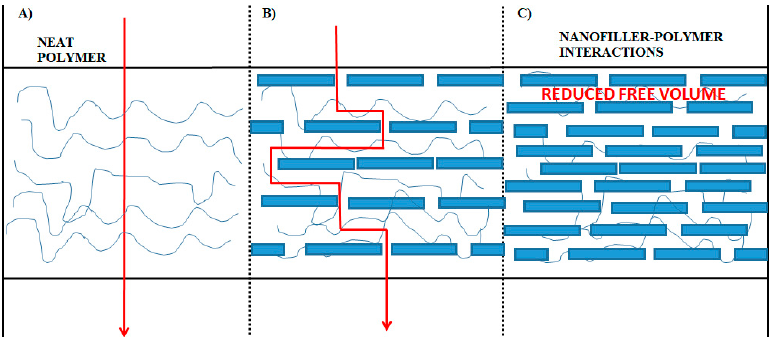
Figure 11. Simplified drawing of the “tortuous path” produced by the incorporation of exfoliated clay nanoparticles into a polymer matrix. ( A ) Neat polymer (diffusing gas molecules follow a pathway perpendicular to the film orientation); ( B ) non-interacting nanocomposite (impermeable platelets hinders direct diffusion); ( C ) interacting nanocomposite (the polymer strands are “immobilized” at the polymer–nanofiller interface and the overall free volume available is reduced.